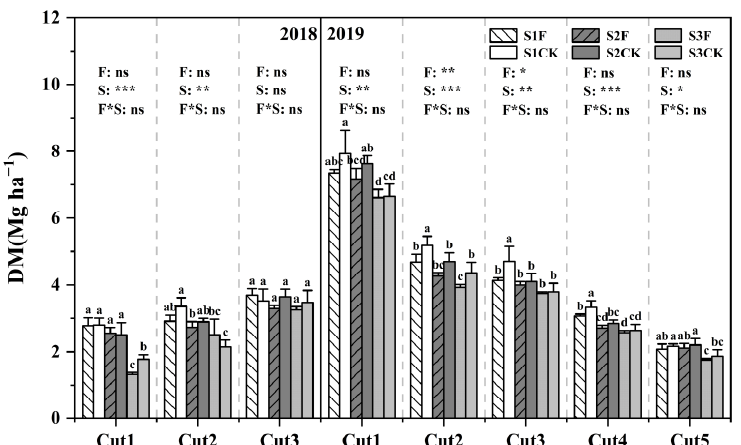
Figure 3. Alfalfa dry matter (DM) of each cut under different treatments in 2018 and 2019, along with their ANOVA results. The error bars represent the standard deviation ( n = 3), and columns with different letters significantly differed at p < 0.05. F: biosolids fertilizer treatment; S: salinity treatment; F*S: the interaction of biosolids fertilizer and salinity. ns, non-significant; *, **, and *** indicate significances at p < 0.05, p < 0.01, and p < 0.001 levels of ANOVA analysis, respectively.